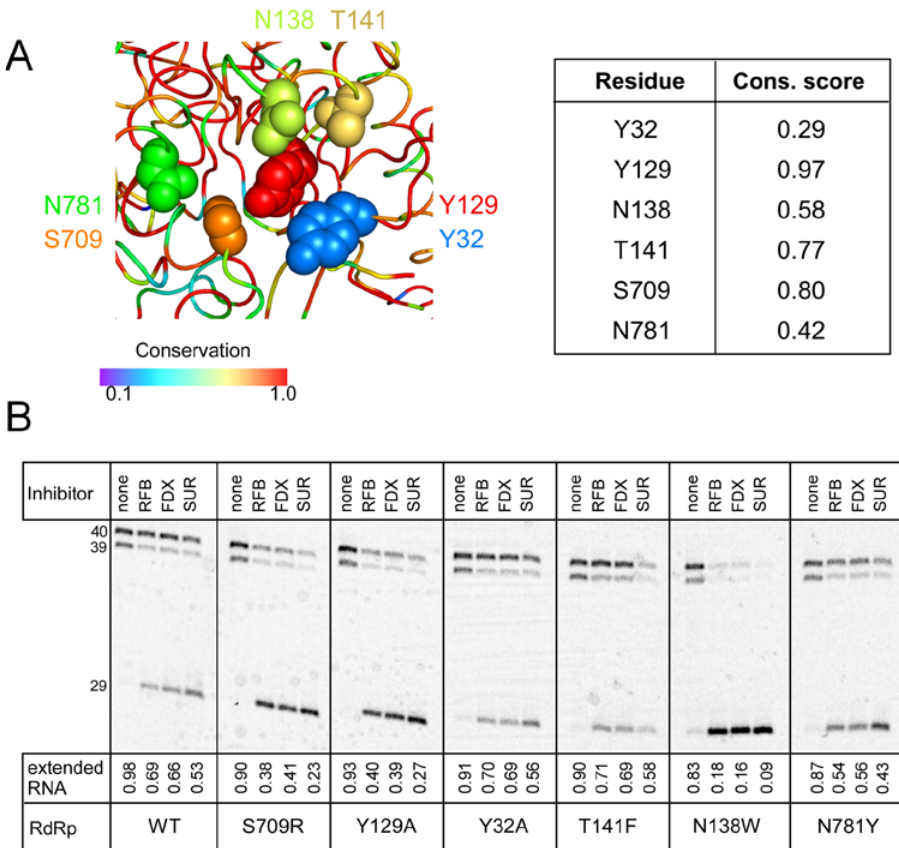
Figure 5. Analysis of the hypothetical hotspot. ( A ). Residues modeled to interact with both FDX and RFB are shown as spheres on the structure of the replicating RdRp (PDB ID: 6YYT), with colors reflecting their conservation scores calculated as described in [23] and shown in the table on the right. ( B ). Effects of substitutions of hotspot residues on RNA synthesis and its inhibition by RFB (100 μM), FDX (30 μM), and SUR (2 μM). A representative gel of 3–4 repeats is shown.